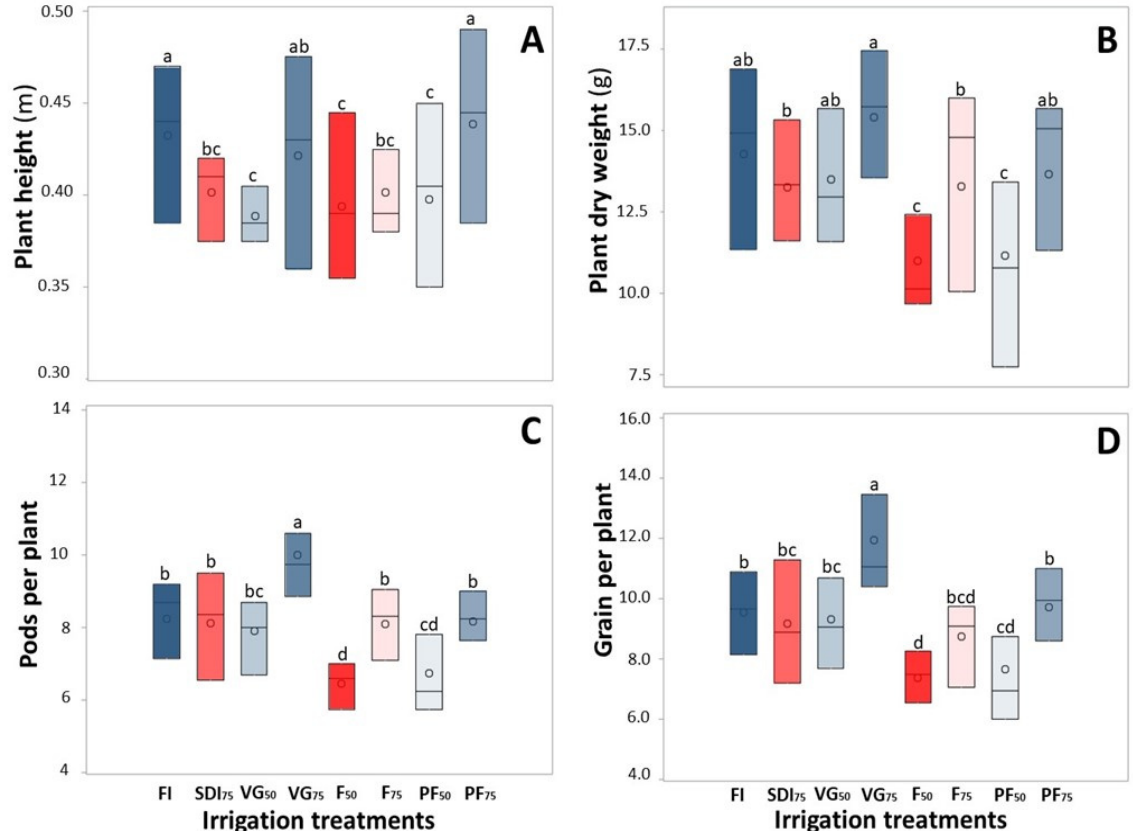
Figure 5. ( A ) Plant height, ( B ) plant dry weight, ( C ) pods per plant, and ( D ) grains per plant of chickpea under different irrigation treatments at Todos Santos, Baja California Sur, Mexico. Vegetative growth (VG), flowering (F), and pod-filling (PF) stages. RDI = regulated deficit irrigation. FI = full irrigation application of 100% ETc during VG, F, and PF. SDI 75 = sustained deficit irrigation applying 75% of ETc during VG, F, and PF. VG 50 = RDI applying irrigation equivalent to 50% of ETc in VG. VG 75 = RDI applying irrigation equivalent to 75% of ETc in VG. F 50 = RDI applying irrigation equivalent to 50% of ETc in F. F 75 = RDI applying irrigation equivalent to 75% of ETc in F. PF 50 = RDI applying irrigation equivalent to 50% of ETc in PF. PF 75 = RDI applying irrigation equivalent to 50% of ETc in PF. abcd : different letters among treatments indicate statistical significance ( p ≤ 0.05, LSD). More intense blue in box plot indicates higher total irrigation volume, and more intense red in box plot indicates lower total irrigation